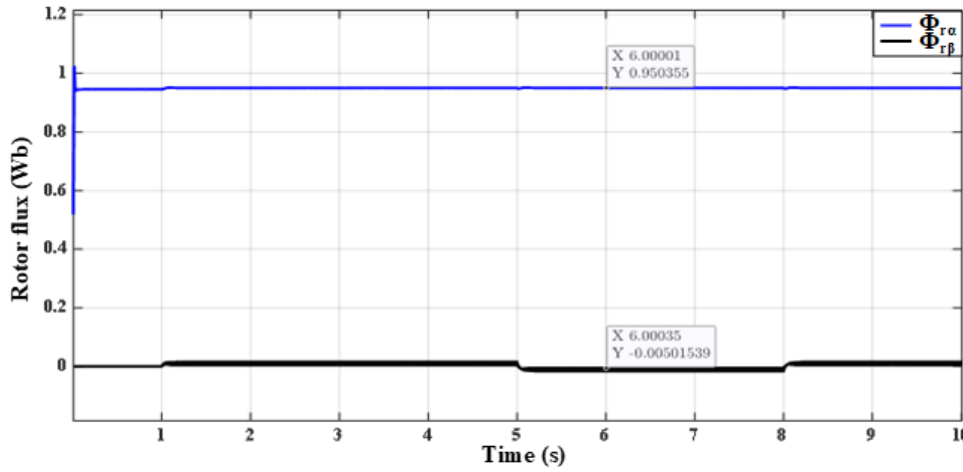
Figure 20. The testbed behaviour of the FOC algorithm for rotor flux vector components